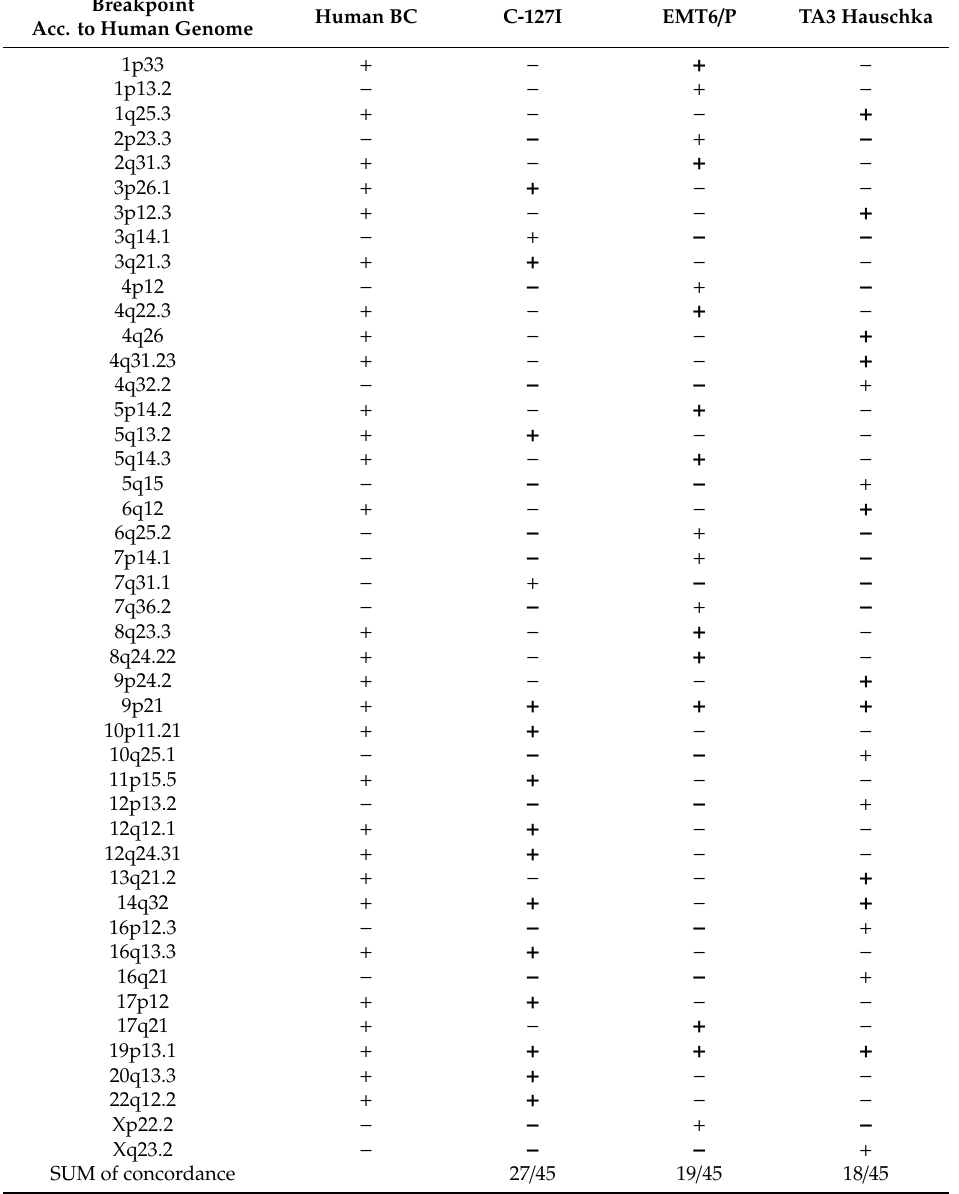
Table 3. Breakpoints in C-127I, EMT6 / P and TA3 Hauschka compared to the observed acquired breaks in human BCs according to the literature [6,7,11,25,26,28–35]: Concordances with human breakpoints are highlighted in